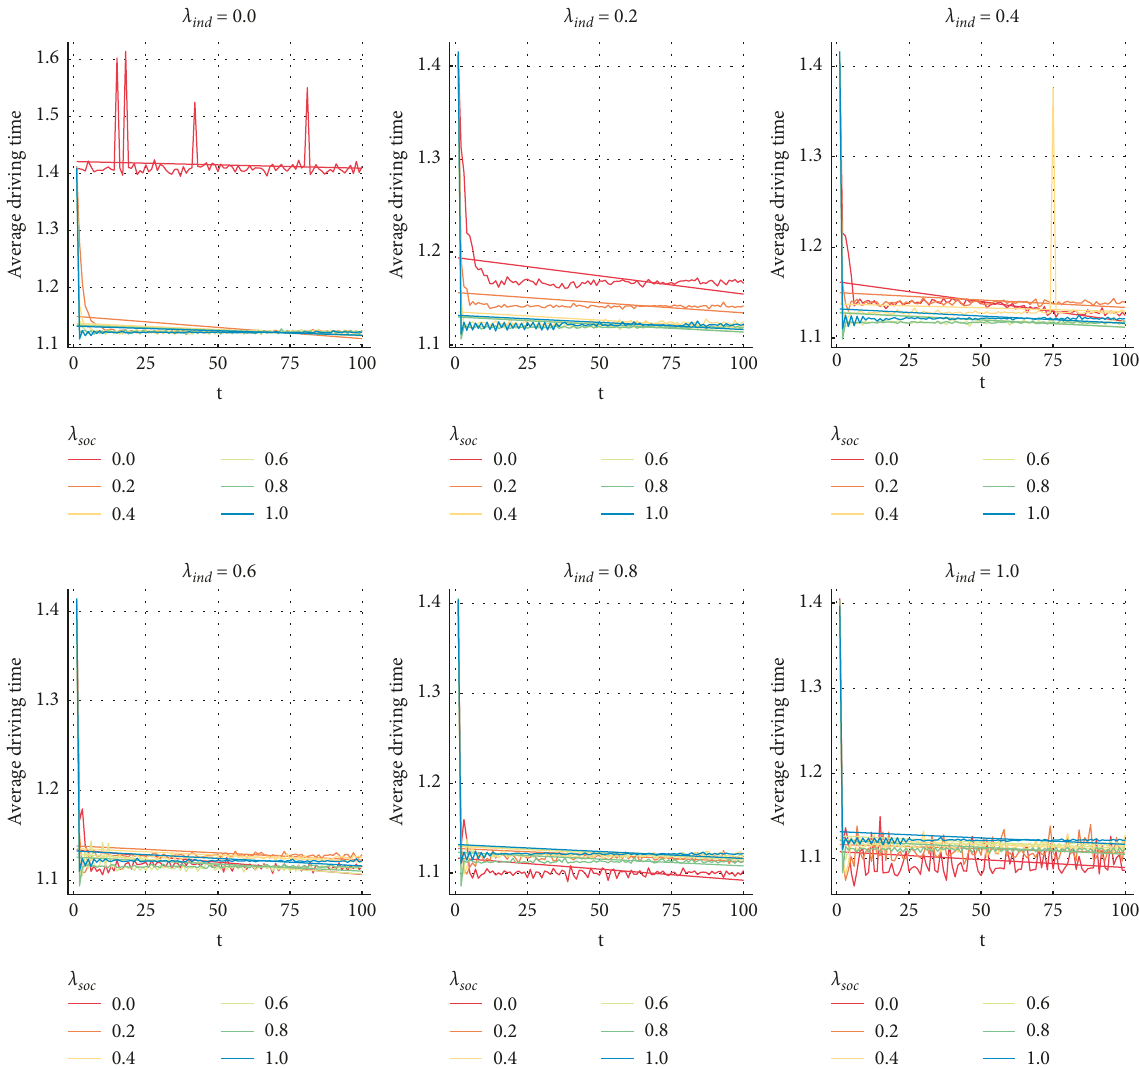
Figure 7: Changes of average driving times during the simulation for different combinations of λ